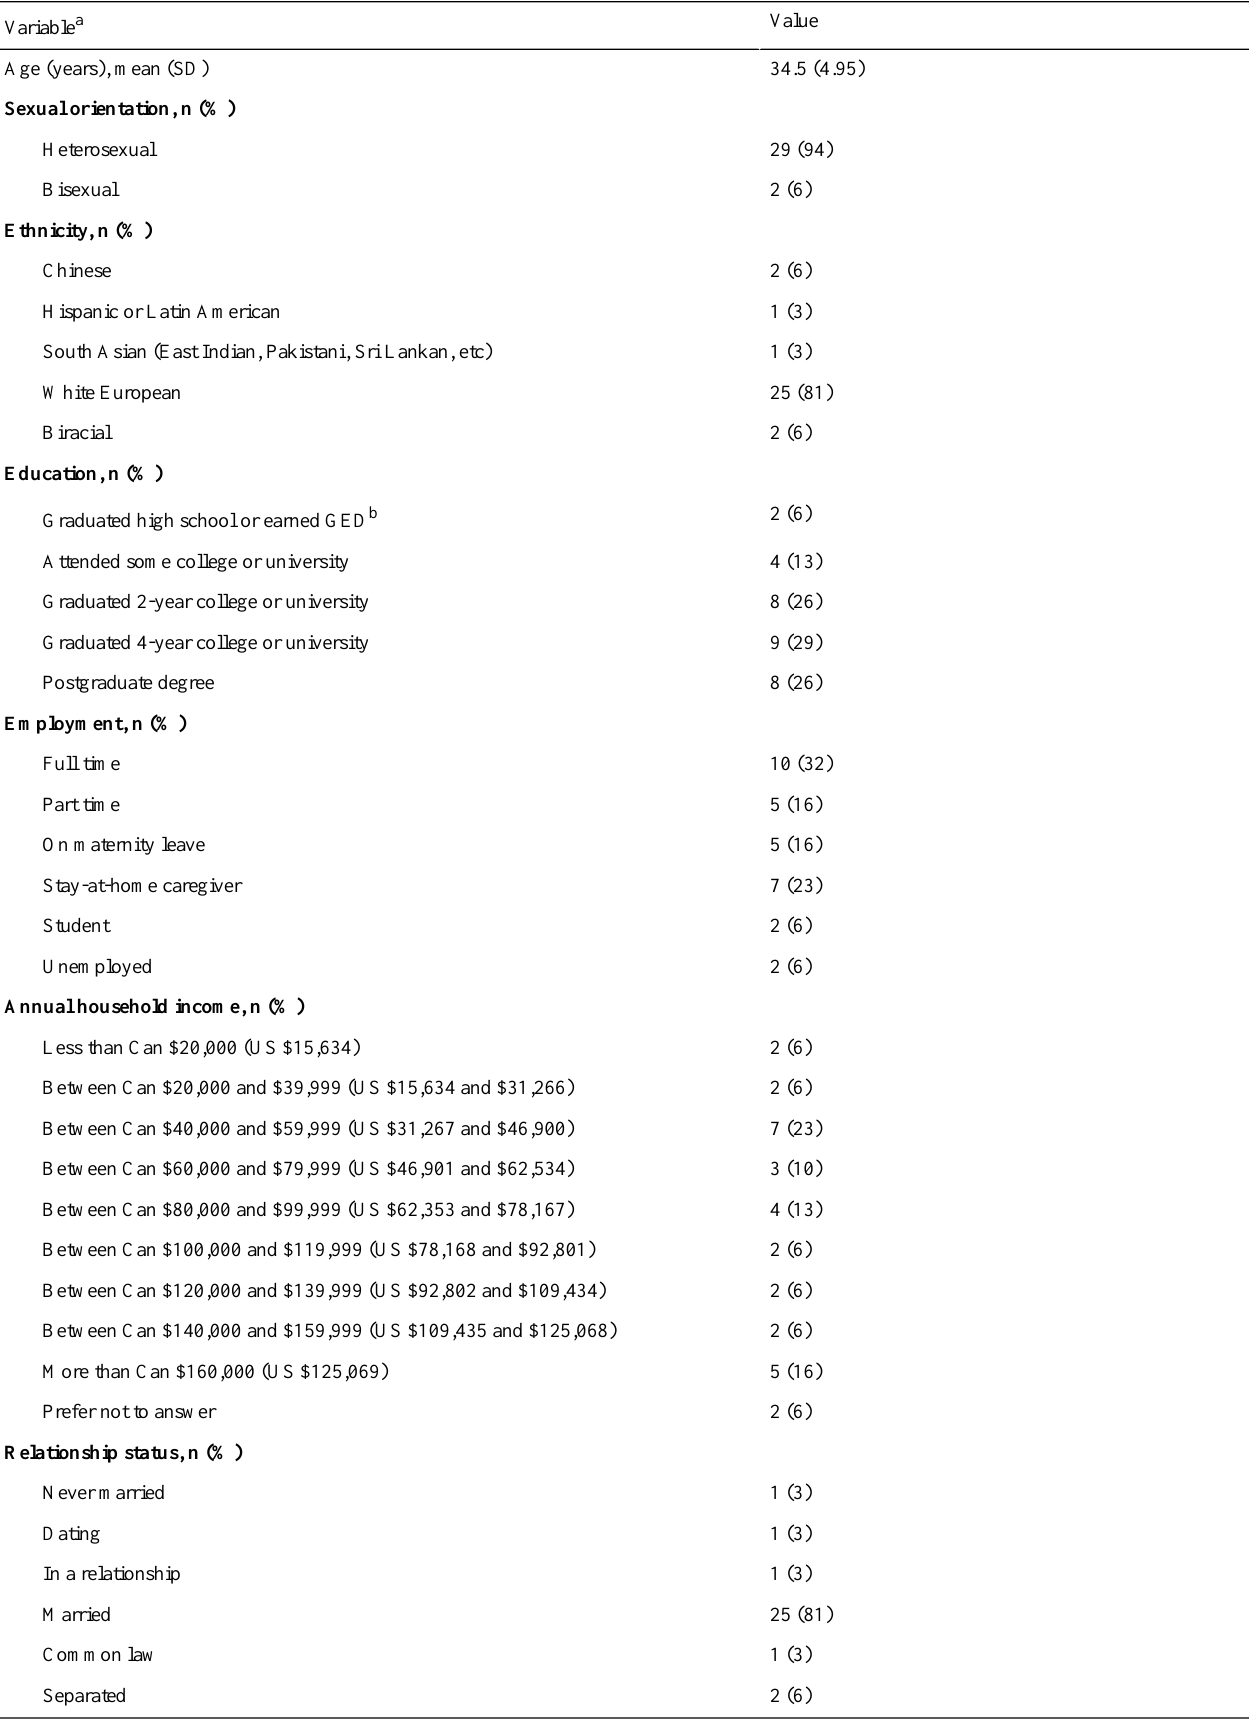
Table 2. Sociodemographic characteristics of focus group attendees